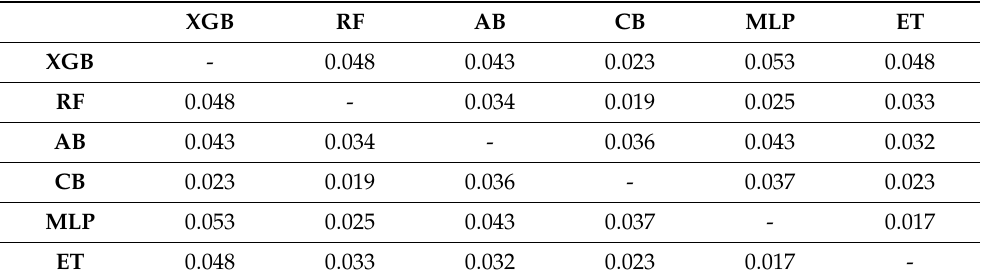
Table 2. P-scores for the paired t -test between classifiers. Each cell represents the p-score obtained after implementing the paired t -test between the corresponding row and column. The left diagonal has been left blank as it represents the paired t -test between a classifier and itself.